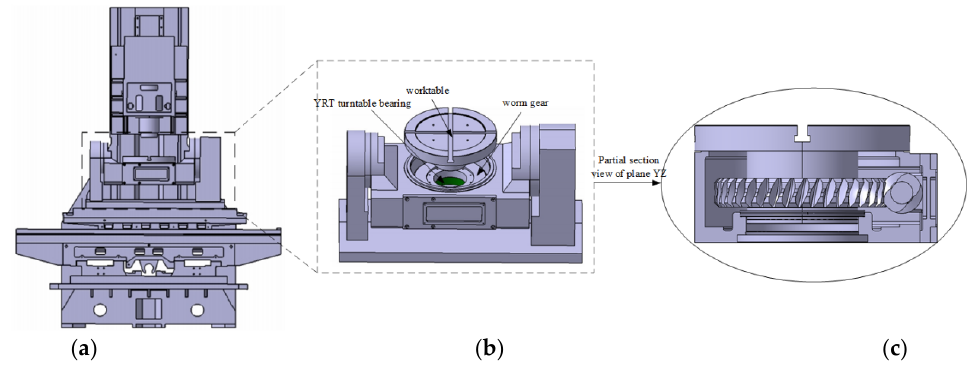
Figure 1. Five-axis machine tool with two-axis rotary table; ( a ) Machine tool three-dimensional model; ( b ) Turntable structure diagram; ( c ) Section view of turntable structure.